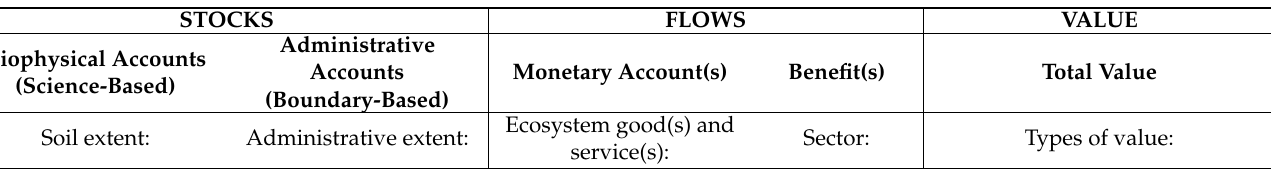
Table 2. A conceptual overview of the accounting framework used in this study (adapted from Groshans et al., 2018 [16]).